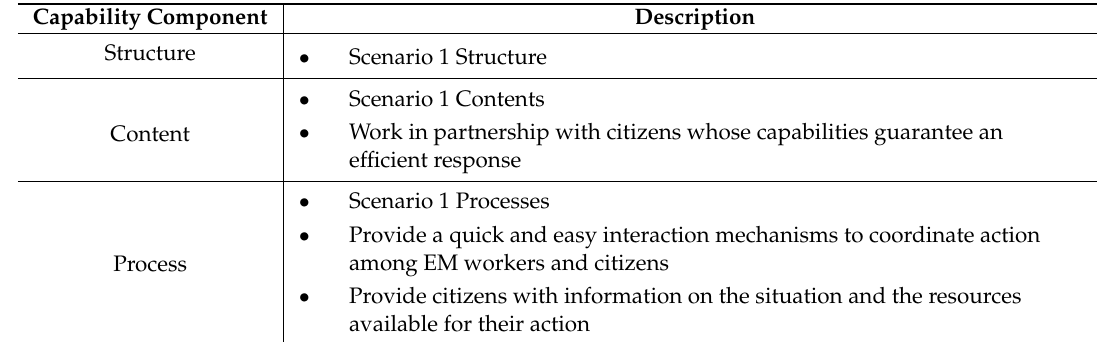
Table 3. Scenario 2: Citizens as